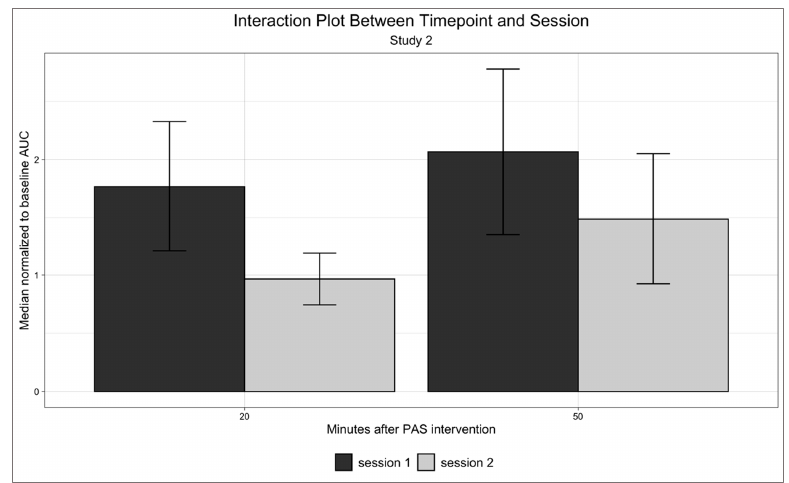
Figure 3. Interaction plot of Study 2. No significant effect of timepoint (F(1, 7) = 0.691, p = 0.433, η p2 = 0.090), session (F(1, 7) = 1.134, p = 0.322, η p2 = 0.139), or interaction between timepoint and session (F(1, 7) = 244, p = 0.636, η p2 = 0.034). Since only two timepoints were used in Study 2, we opted to graph the results with bar graphs here. Error bars represent standard errors.